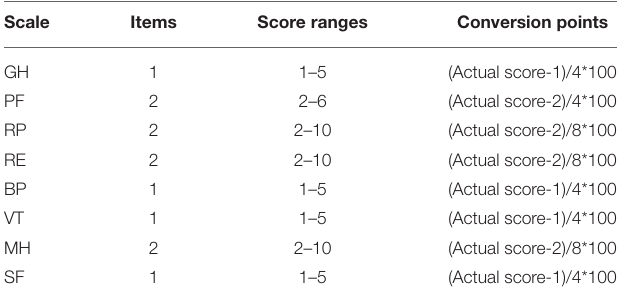
TABLE 2 | Conversion table of each dimension of the 12-item Short Form Health Survey version 2 (SF-12v2).